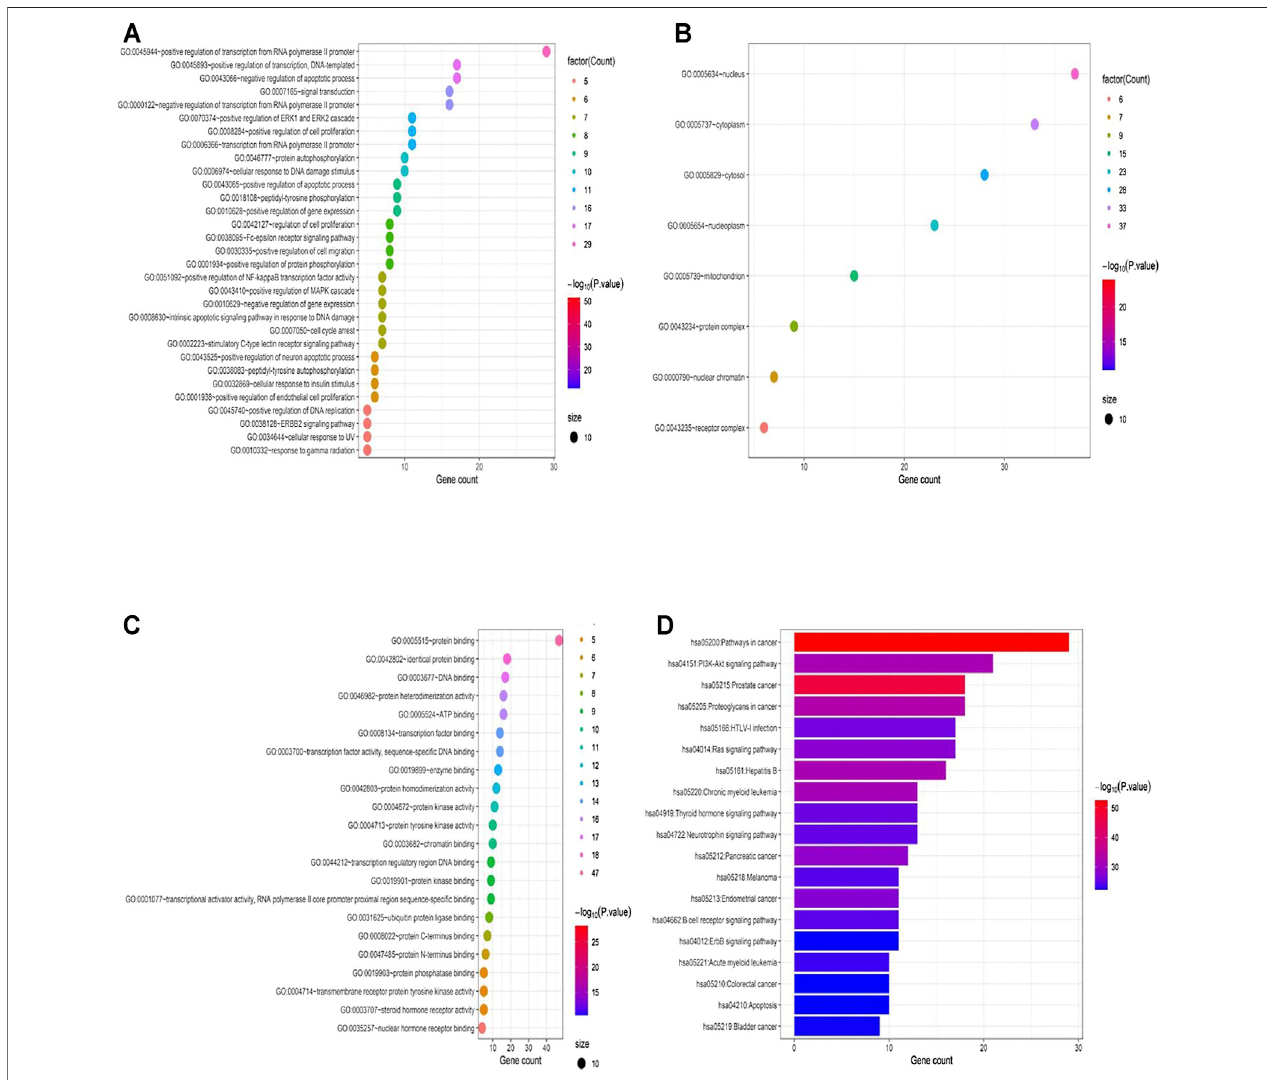
FIGURE2| Compound – targetinteractionnetworkandpreliminarygeneontology(GO)analysisofdrugtargets. (A) thepotentialtargetsofLWWLmainlydistributed inthecellularcomponent, (B) thepotentialtargetsofLWWLcanbindandactivatemolecularfunction, (C) thepotentialtargetsengagedinthebiologicalprocess,and (D) KEGG pathway analysis of